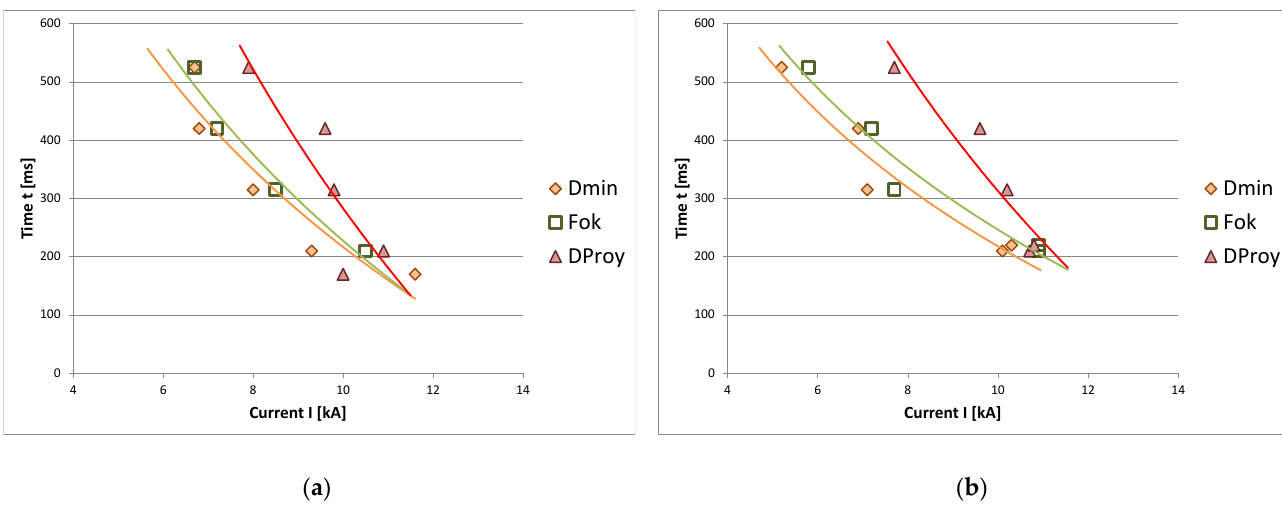
Figure 4. Key indicators for the lobes obtained after 556 welding points and 1360 tests including minimum diameter (diamond), projection diameter (triangle) and optimal welding (square). The lines show the welding lobes following ISO 18278-2 [37] and ISO 14327 [38] AHSS CP1000 G10/10 steel weldability lobes: ( a ) f = 1000 Hz; ( b ) f = 7000 Hz.